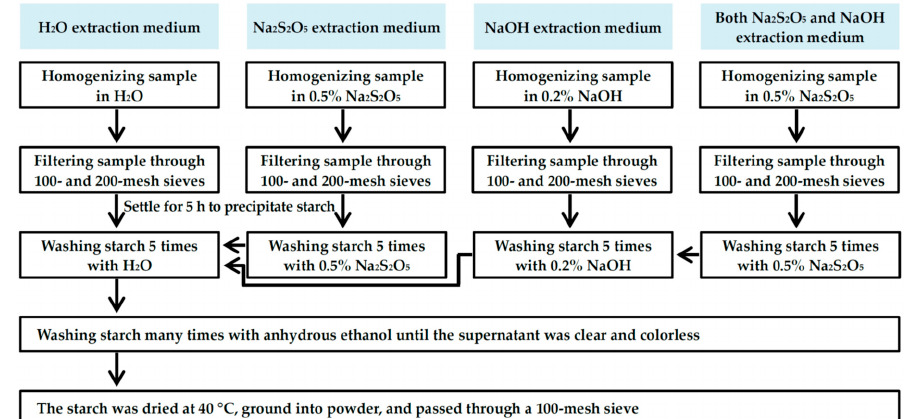
Figure 9. Procedure for starch isolation from root tubers with different extraction media.